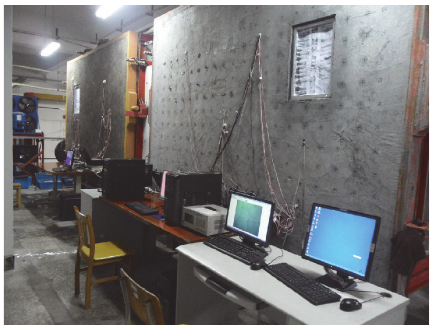
Figure 6: Data acquisition system of temperature and